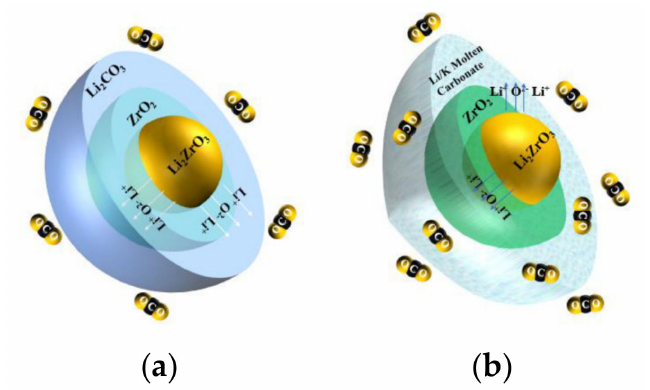
Figure 13. Double shell model of CO 2 sorption by Li 2 ZrO 3 ( a ) without modification and ( b ) with K 2 CO 3 addition. (Reprinted with permission from [4]. 2021, Wang et al.). Table 6. Properties of CaO, Li 4 SiO 4 , Li 2 ZrO 3 , KLiZrO 3 and Na 2 ZrO 3 sorbents. (Reprinted